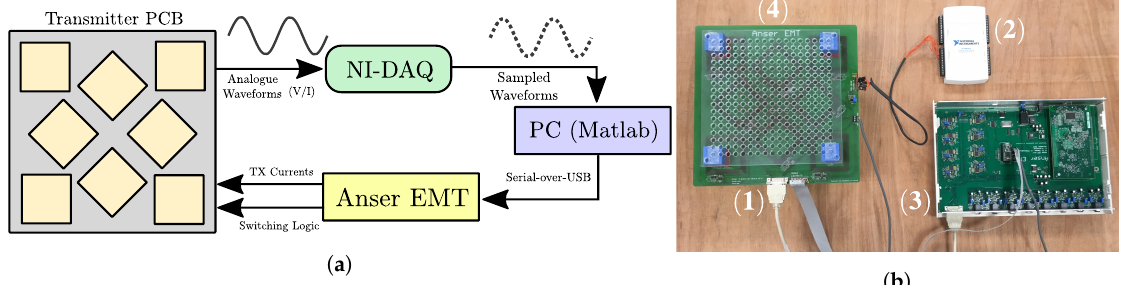
Figure 10. ( a ) Block diagram of the experimental setup. ( b ) Photograph of the experimental setup of the modified transmitter board connected to the Anser EMT system. (1) The modified transmitter board with extra connections to enable coil switching. (2) The National Instruments DAQ connected to the instrumentation amplifier outputs of the transmitter. (3) The Anser EMT tracking system unit with embedded Teensy 3.2 controller. (4) 6 mm Perspex planar board used for sensor position